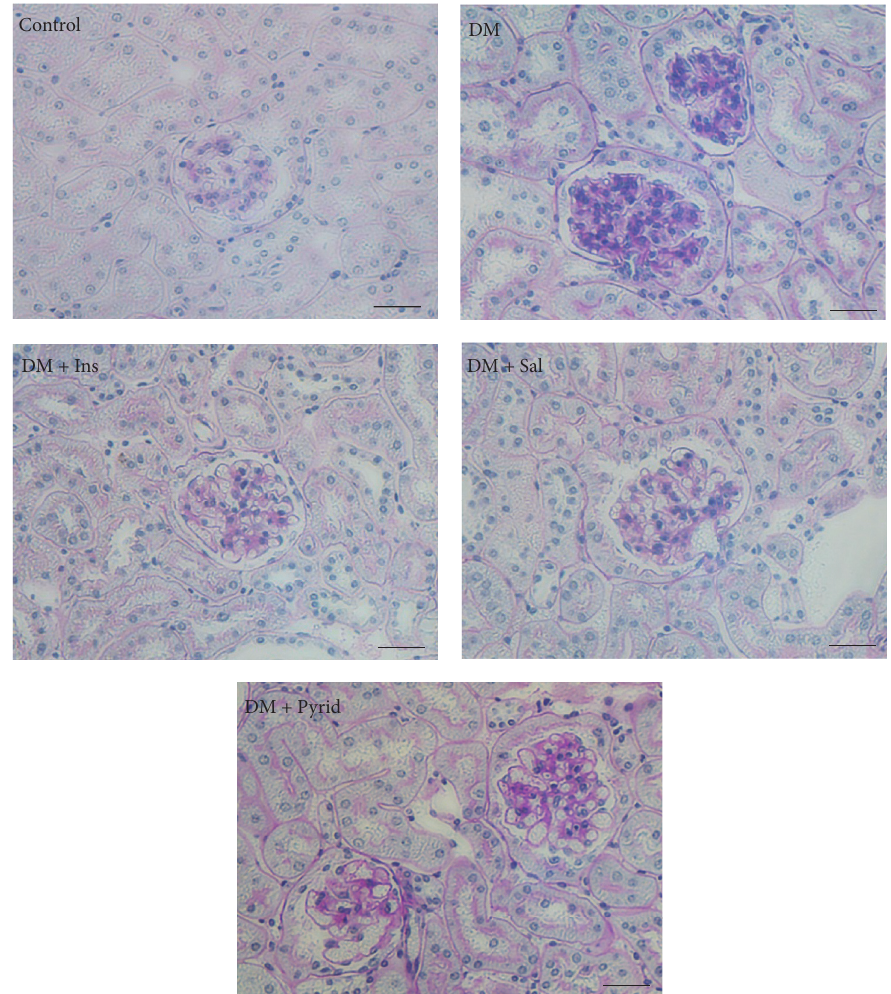
Figure 3: Periodic acid-Schiff (PAS) stain of kidneys. Nondiabetic control (Control), diabetic mice without treatment (DM), diabetic mice with insulin treatment (DM + Ins), diabetic mice with salicylate treatment (DM + Sal), and diabetic mice with pyridoxamine treatment (DM + Pyrid). Bar indicates 50 𝜇